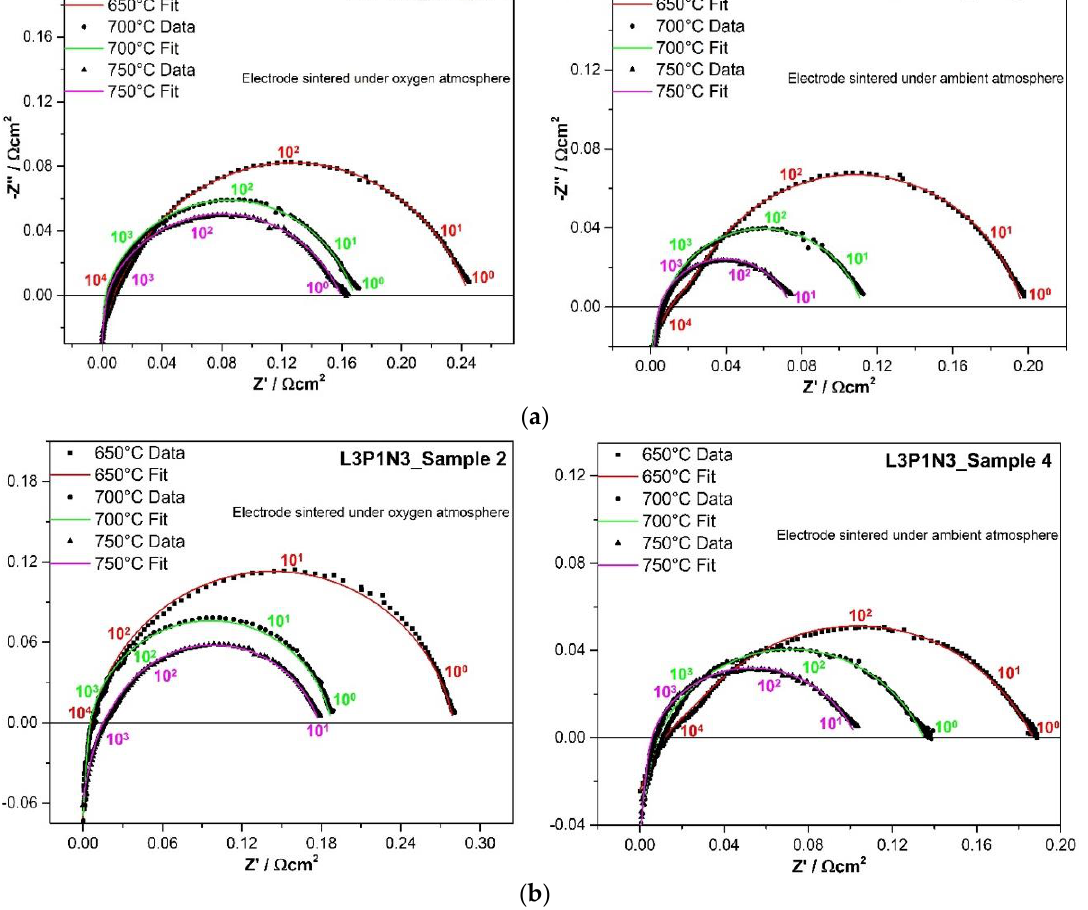
Table 3. Systematic improvement in half-cell performance on increasing Pr content across different compositions and improvement in ASR performance within a composition by reducing the effective cell sintering time.